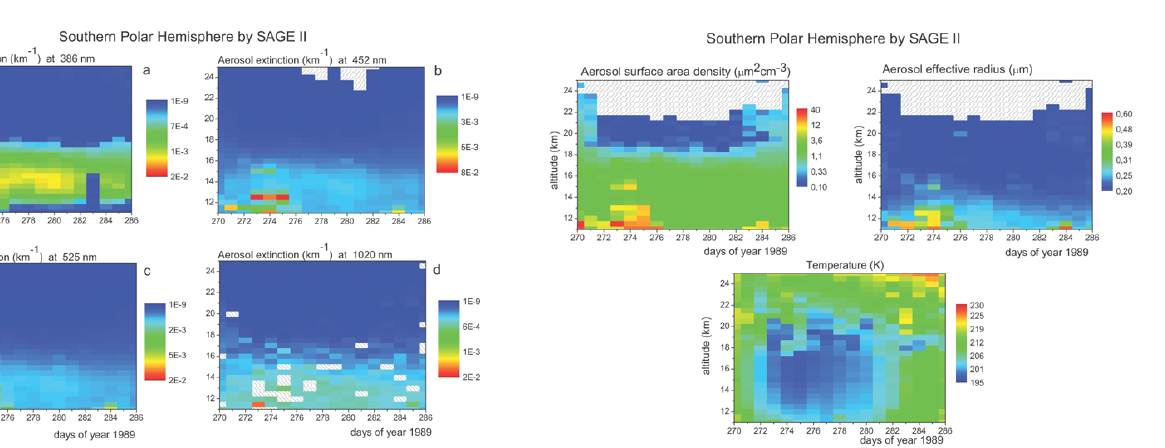
Fig. 4. Aerosol microphysical properties and temperature obtained by SAGE II data sets. Logarithmic color scale is shown on the right of each panel. Upper panel: variations of surface area density and effective aerosol radius. Lower panel: variations of